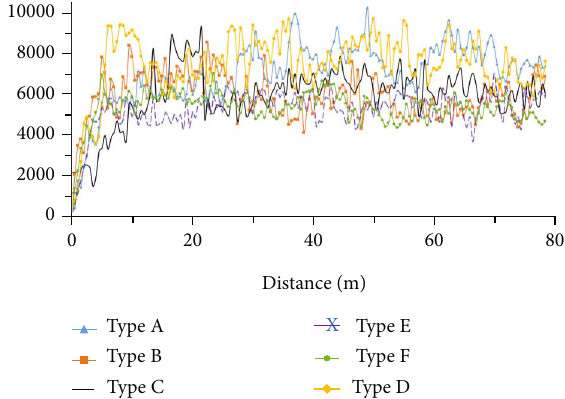
Figure 12: Variation of subsoiling resistance with distance for six subsoilers at 5km/h speed and 30cm